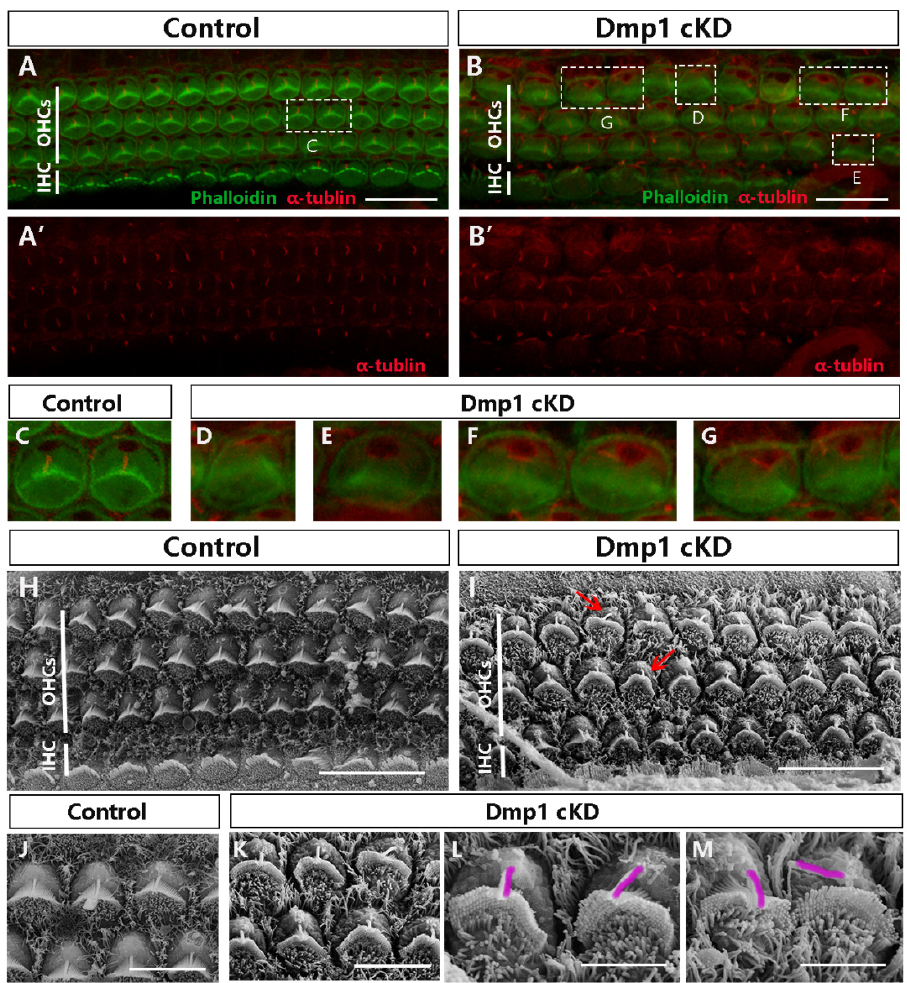
Figure 3. The proper positioning of kinocilia was affected in Dmp1 cKD mice. ( A , B ): Confocal microscope images from the basal regions of Dmp1 cKD and littermate control mice cochlea, Acety- lated tubulin staining was singly showed in ( A (cid:48) , B (cid:48) ) (Acetylated tubulin: red. Phallodin: green.) ( C – G ): The amplification of the white dashed box in ( A , B ). In normal control cochlea, hair cells had a single kinocilium located at the vertex of the stereociliary bundles ( C ). By contrast, in the Dmp1 cKD mice, the kinocilia were misplaced and deviated from the vertex of the V-shape hair bundles, and the bundles were deformed, with no clear vertex ( D , F , G ). Several hair cells also had deletions of kinocilium ( E ). ( H – M ): SEM of outer hair cells from basal cochlear turns of Dmp1 cKD and control mice at P1 using scans with different magnifications. ( H , I ): 3 k magnification. ( J , K ): 8 k magnification. ( L , M ): 15 k magnification. Red arrows showed the abnormal positioning of kinocilia.Under the higher magnification, the separation between kinocilia and stereociliary bundles was clearly noted. The kinocilia were outlined (purple). Scale bars: ( A – I ): 10 µ m; ( J , K ): 5 µ m; and ( L , M ): 3 µ